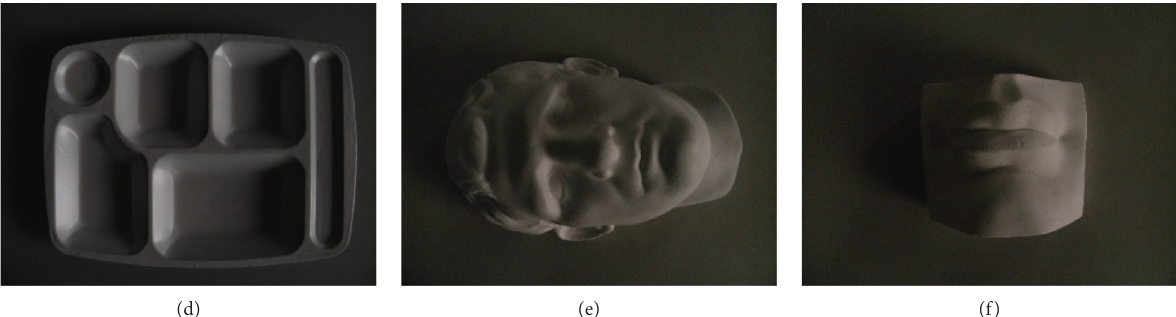
Figure 13: Different objects used in object reconstruction experiments. (a) Four stairs. (b) Polygon. (c) Yellow bottle. (d) Tableware. (e) Head model. (f) Mouth